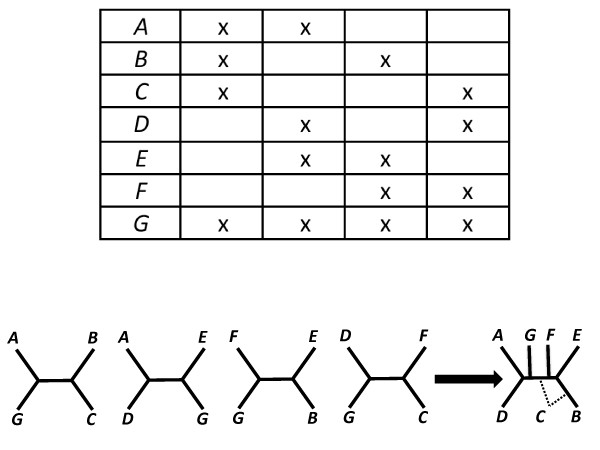
Decisiveness and phylogenetic groves. Pattern of taxon coverage shown is not decisive for any tree but is a phylogenetic grove sensu Ané et al. [56]. There are five binary trees like the tree in the lower right, which differ only in the placement of taxon C (two of these are indicated by alternative placements of dashed lines). Although taxon coverage is not decisive for any of the five trees, there is no ambiguity about the relationships of the five trees if taxon C is ignored. Example modified from [56,57].